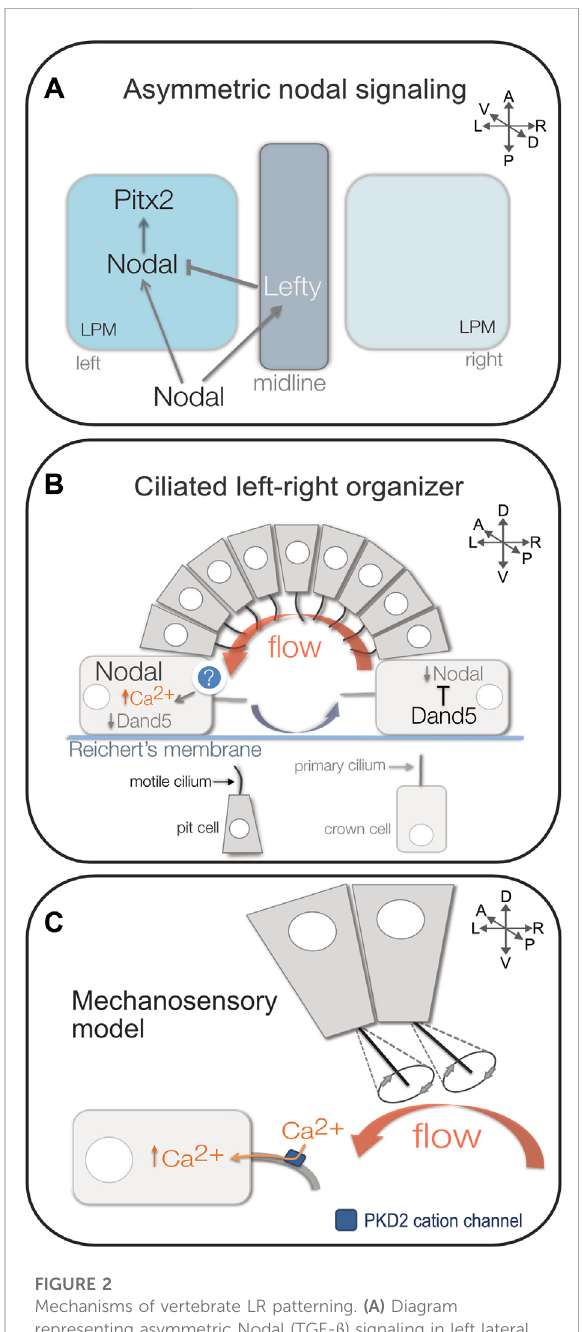
FIGURE 2 Mechanisms of vertebrate LR patterning. (A) Diagram representing asymmetric Nodal (TGF- β ) signaling in left lateral plate mesoderm (LPM). Nodal activates its own transcription as well as the Nodal antagonist Lefty in the embryonic midline that restricts Nodal to the left side, and the transcription factor Pitx2 that can regulateasymmetric morphogenesis oforgans such as the heart and gut. (B) Diagram of the mouse left-right organizer (referred to as the node/PNC). Epithelial pit cells with motile cilia generate a leftward fl uid fl ow (red arrow) in a cavity covered by Reichert ’ s membrane. Return fl ow (blue arrow) occurs away from the ciliated epithelium. Leftward fl ow is sensed in larger crown cellsthathaveimmotileprimarycilia.Inleft-sidedcrowncells, fl ow induces increased Ca 2+ fl uxes and degradation of the Nodal inhibitor Dand5. Loss of Dand5 increases Nodal expression in left ( Continued )